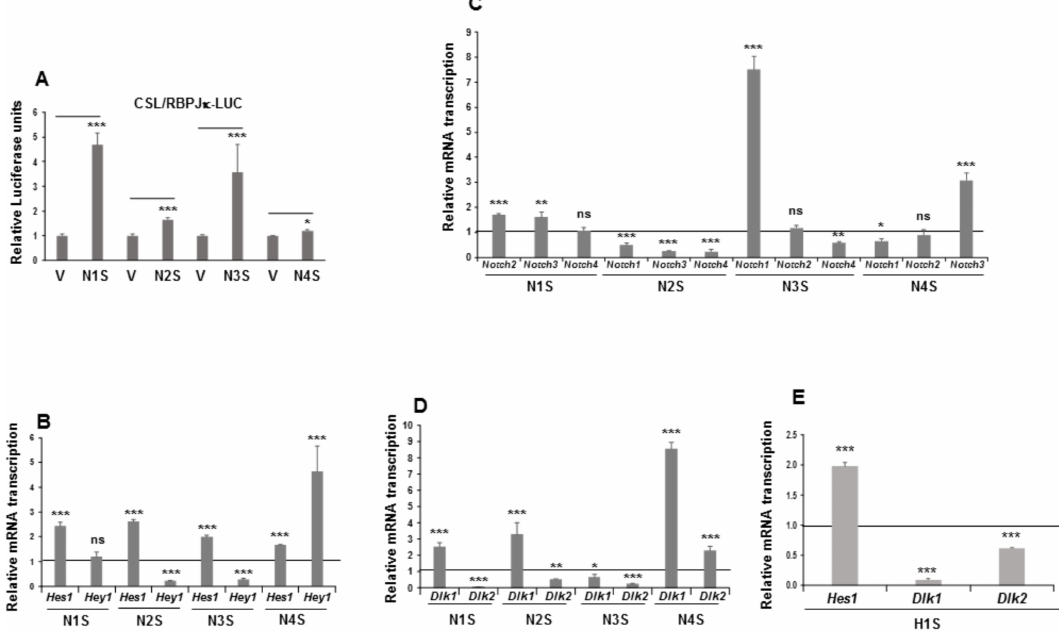
Figure 2. NOTCH signaling in mesenchymal C3H10T1 / 2 cells stably overexpressing NOTCH receptors or the HES1 protein. ( A ) NOTCH receptors’ transcriptional activity, as measured by luciferase assays, in each of the four stably Notch -transfected pools. The relative luciferase activities were always normalized to renilla levels. ( B ) qRT-PCR analysis of the relative Hes1 and Hey1 mRNA transcription levels in each of the stably Notch -transfected pools. ( C ) qRT-PCR analysis of relative mRNA transcription levels of Notch genes in the stable Notch1 transfectant (N1S), the stable Notch2 transfectant (N2S), the stable Notch3 transfectant (N3S), and the stable Notch4 transfectant (N4S). ( D ) qRT-PCR analysis of Dlk1 (DELTA-like 1 homolog) and Dlk2 (DELTA-like 2 homolog) mRNA transcription levels in the stable Notch transfectants. ( E ) qRT-PCR analysis of the relative Hes1 and Dlk mRNA transcription levels in the stable Hes1 gene transfectant (H1S). All these assays were performed using non-di ff erentiated cells. Data in qRT-PCR assays were normalized to P0 mRNA transcription levels. The fold activation or inhibition in all assays was measured relative to levels in non-di ff erentiated empty-vector-transfected cells, set arbitrarily at 1 (horizontal black line or V). Data are shown as the mean ± SD of at least three biological assays performed in triplicate. The statistical significance of Student’s t -test results is indicated (* p ≤ 0.05, ** p ≤ 0.01, *** p ≤ 0.001). Non-statistical significance is indicated by